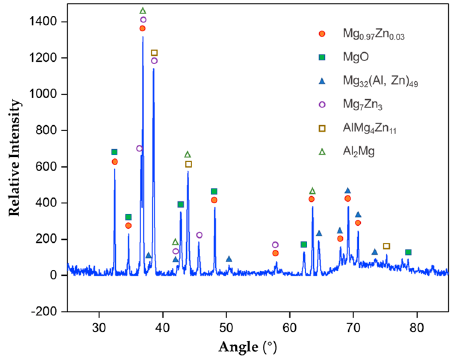
Figure 6. The XRD pattern of the intermetallic layer fabricated by surface alloying on the AZ91D magnesium alloy with ZnO as the only Zn donor.